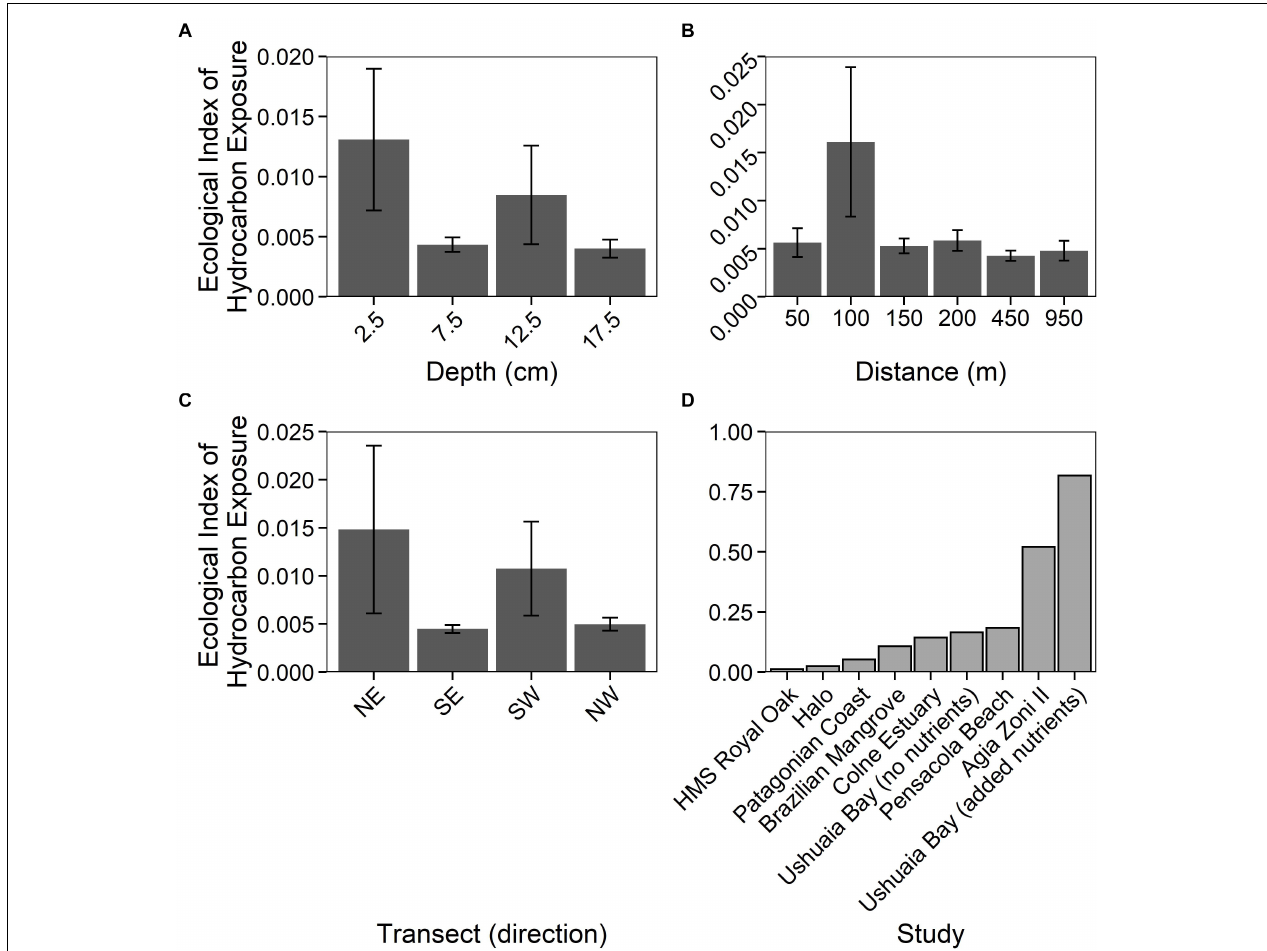
FIGURE 5 | Ecological Index of Hydrocarbon Exposure (EIHE) (ratio up to 1) representing relative abundance of oil-degrading/associated Bacteria, (Lozada et al., 2014) measurements ( ± SE, n = 4), for sediments sampled around the shipwreck HMS Royal Oak (located in Scapa Flow, Scotland, United Kingdom, November 2019), over a 17.5 cm depth profile (A) , a 950 m transect (where sediments further away act as controls) (B) , and given the transect direction (C) . Additionally, a comparison between the HMS Royal Oak EIHE and other studies investigating oil-polluted environments (D) : “HMS Royal Oak ” (present study, surface sediments), “Halo” (Hamdan et al., 2018), “Patagonian Coast” (Lozada et al., 2014), “Brazilian Mangrove” (Dos Santos et al., 2011), “Colne Estuary” (Coulon et al., 2012), “Ushuaia Bay (no nutrients)”, “Pensacola Beach” (Kostka et al., 2011), “Agia Zoni II” (Thomas et al., 2020) and “Ushuaia Bay (added nutrients)” (Guibert et al., 2012).